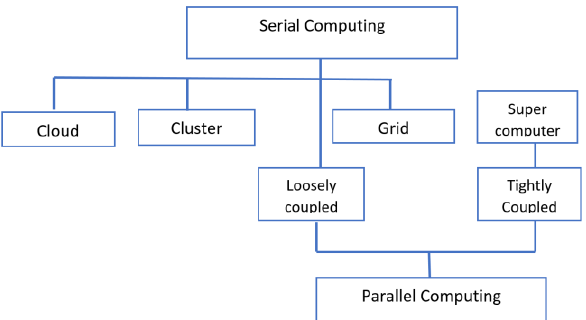
Figure 1. Computational arrangement in clusters, grids, clouds, and supercomputers (adapted from (Karimi,